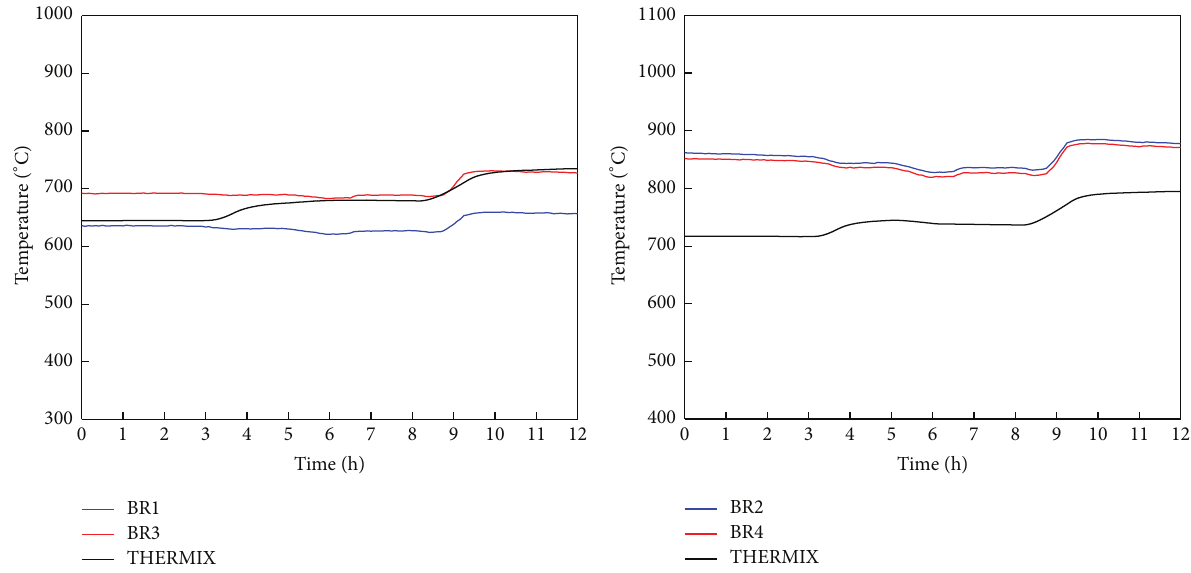
Figure 14: Temperature transient of the bottom